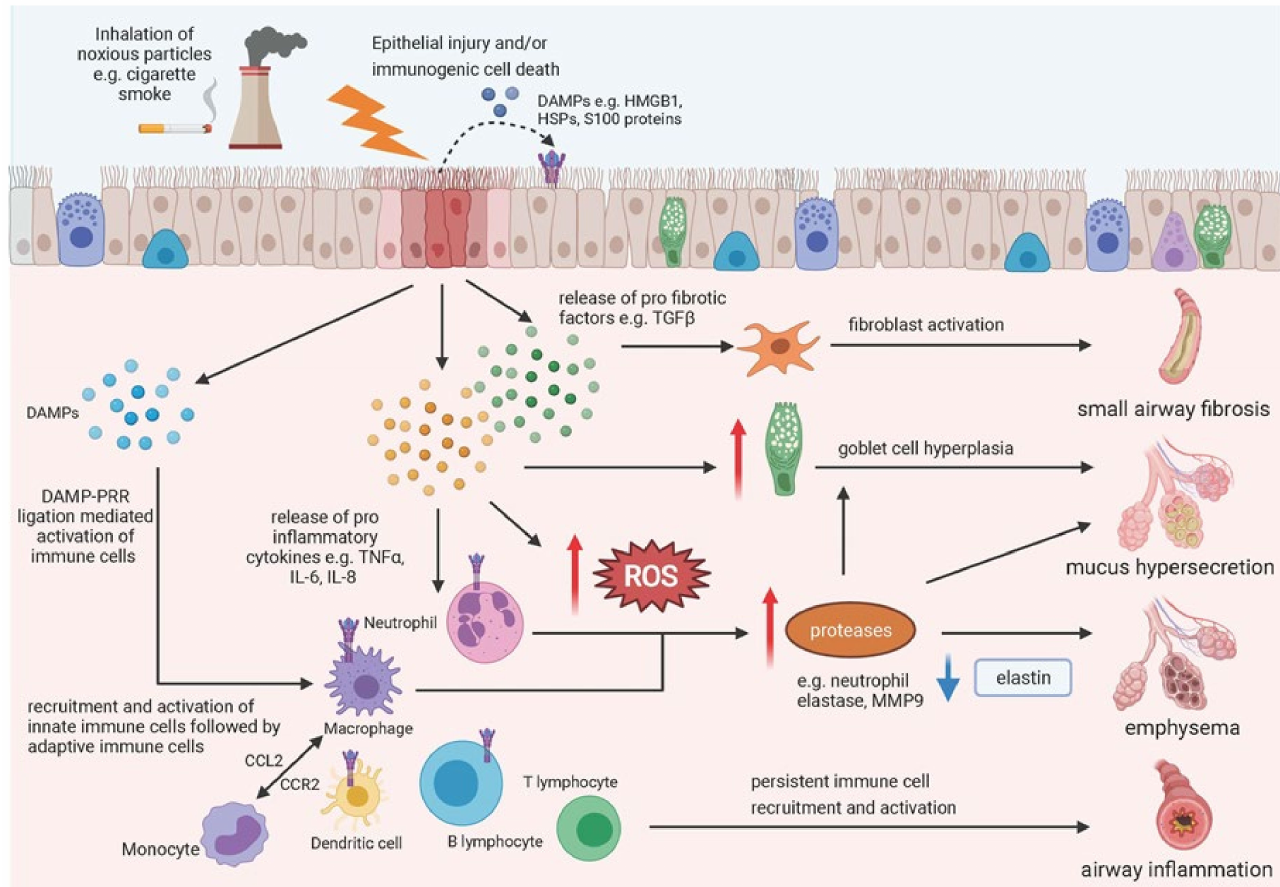
Figure 1. Schematic diagram of downstream effect of epithelial damage in COPD. Inhalation of noxious particles (e.g., cigarette smoke) is a major risk factor in the development of COPD, causing epithelial injury, immunogenic cell death and the release of DAMPs and pro inflammatory/fibrotic chemokines/cytokines into the extracellular space. DAMPs can activate pattern recognition receptors (PRRs) on neighbouring epithelial cells and immune cells, directly stimulating the release of chemokines and cytokines to activate the immune system. Several mechanisms have been implicated in the development of COPD, including the influx of inflammatory cells, proteolytic imbalance and oxidative stress, resulting in airway inflammation, emphysema, mucus hypersecretion and small airway fibrosis. Created using Biorender.com (accessed on 5 October